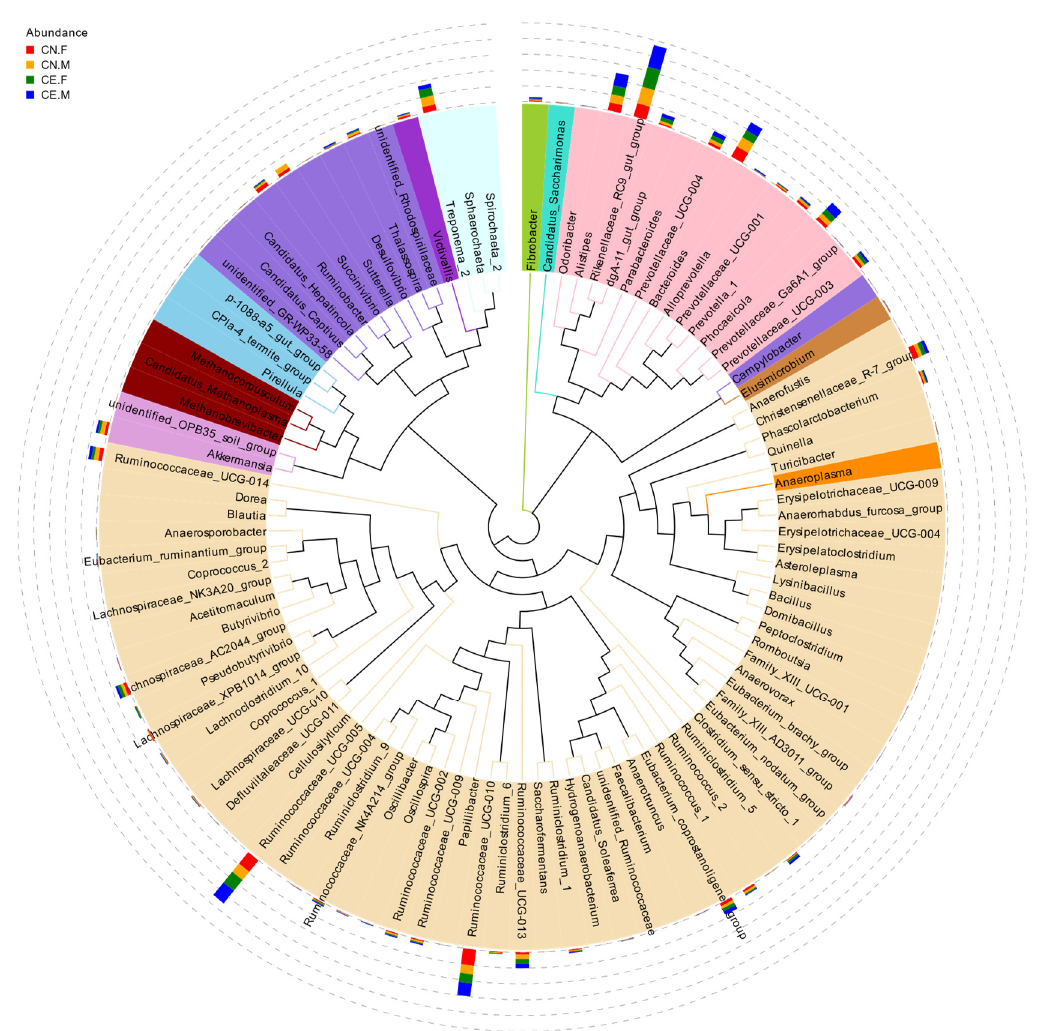
Figure 4. Phylogenetic relationships between species at the genus level. An evolutionary tree was established using the relative abundances at the genus level and the top 100 operational taxonomic units (OTUs). The colors represent the phyla to which the OTUs belong.